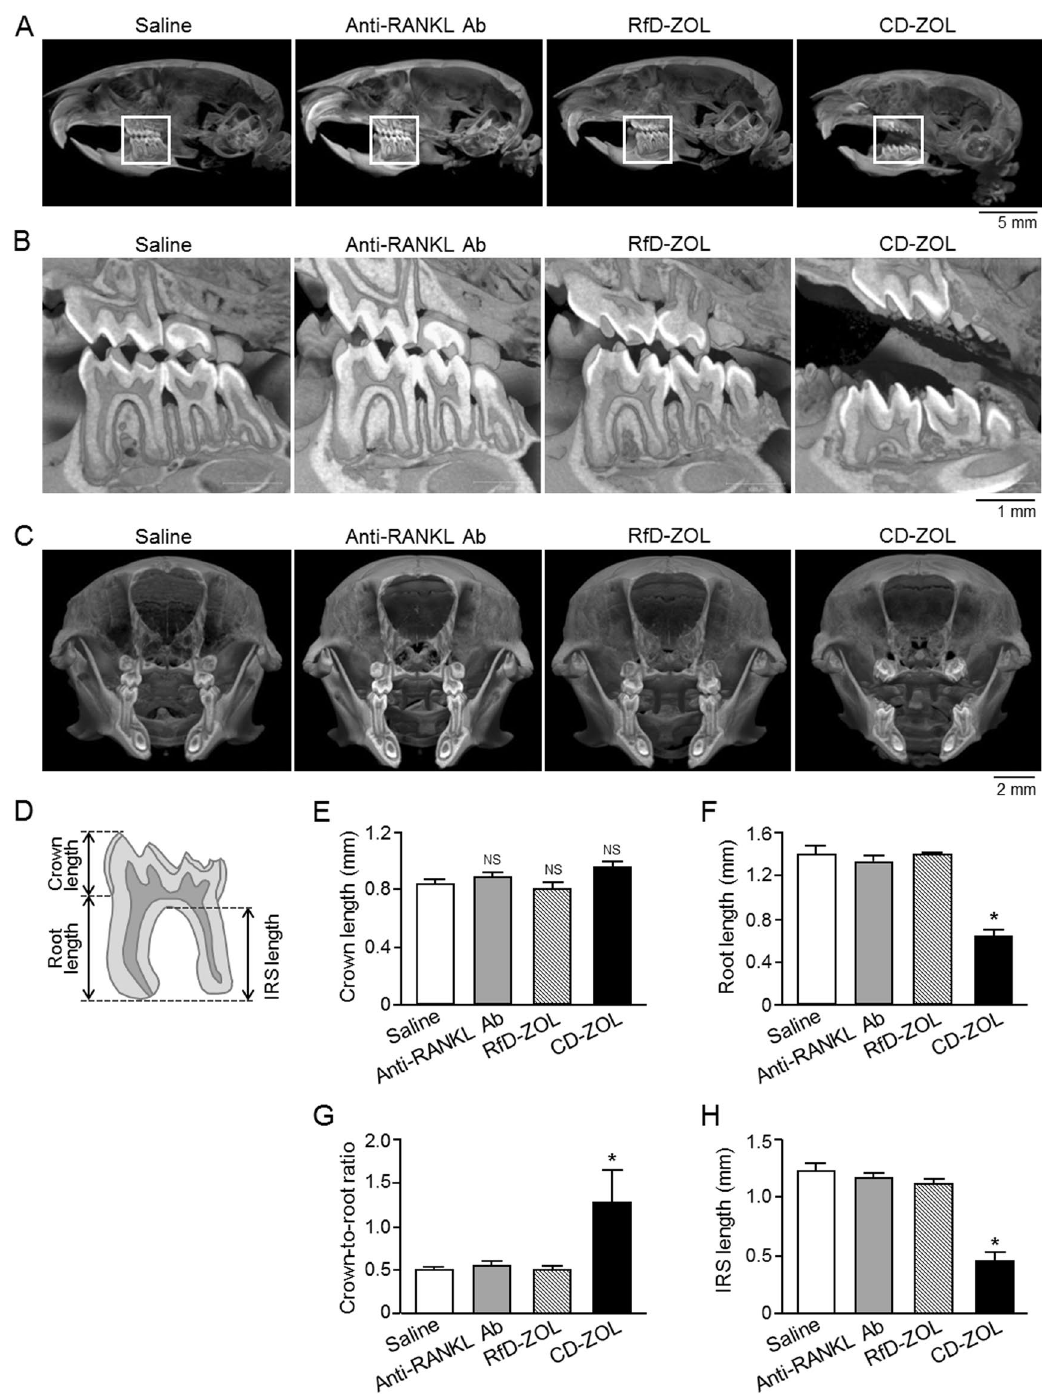
Figure 3. Effects of long-term administration of anti-RANKL antibody or ZOL on cranial bone and tooth development. Micro-computed tomography ( μ CT) findings of ( A ) sagittal facial bone, ( B ) sagittal left molar, and ( C ) coronal section in 8-week-old mice administered saline, anti-RANKL antibody (Ab) at 2.5 mg/kg, RfD-ZOL at 0.08 mg/kg, or CD-ZOL at 3.0 mg/kg weekly for 7 weeks. ( B ) Higher magnification of white- boxed regions in ( A ). Representative findings are shown in ( A – C ). ( D ) Illustration of first molar measurement positions. ( E ) Crown length (between first mesial-buccal crown tip point and cement-enamel junction), ( F ) root length (between cement-enamel junction and lowest root tip point of mesial-buccal root) were measured, and ( G ) crown-to-root ratio and ( H ) interradicular septum (IRS) length (between buccal furcation area and lowest root tip point of mesial-buccal root) of the lower first molar were determined in 8-week-old mice administered saline (n = 6), anti-RANKL Ab (n = 5), RfD-ZOL (n = 6), or CD-ZOL (n = 5). Statistical differences were assessed by one-way ANOVA with Tukey-Kramer’s test. * Statistically significant different from compared to all the other groups, p < 0.05. Error bars represent